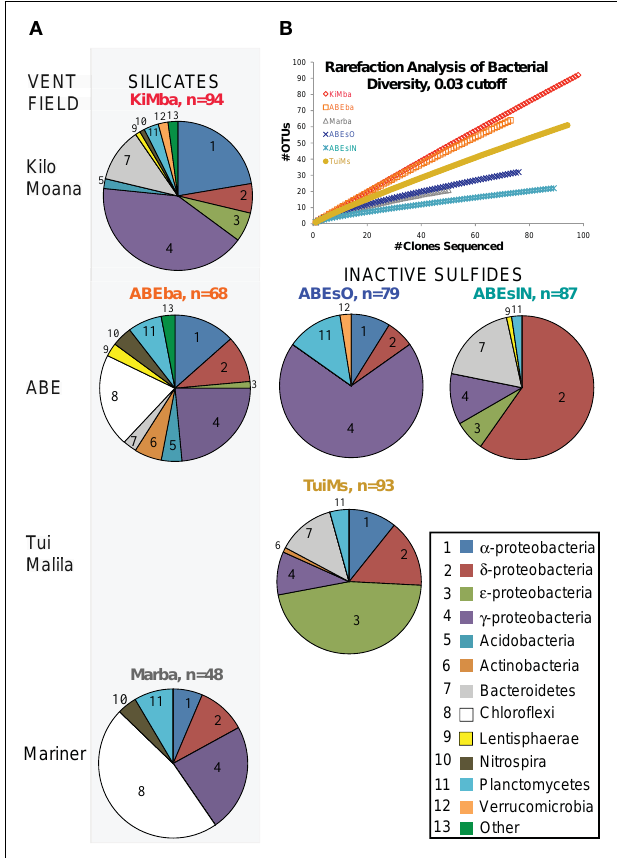
FIGURE 4 | (A) Bacterial distributions recovered from samples in this study. Samples are arranged in rows from north to south in Lau Basin and the silicate samples are in the left column of pie charts while the inactive sulfides are to the left.The number of clones recovered per sample is indicated next to the sample name. Bacterial phyla/class are indicated by the numbers in each pie slice, according to the key at bottom right. (B) Rarefaction analysis of clone libraries from this study. Clones were aligned, pre-clustered (Huse et al., 2010), and analyzed at the 97% similarity level using the average neighbor method in the software mothur (Schloss et al.,